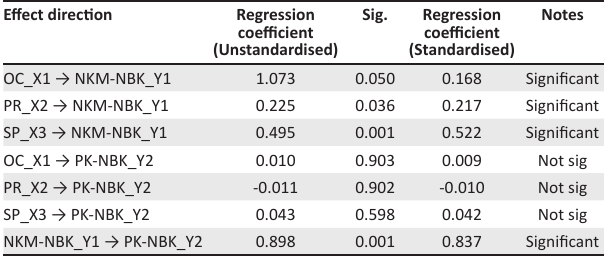
TABLE 3: Research hypotheses testing